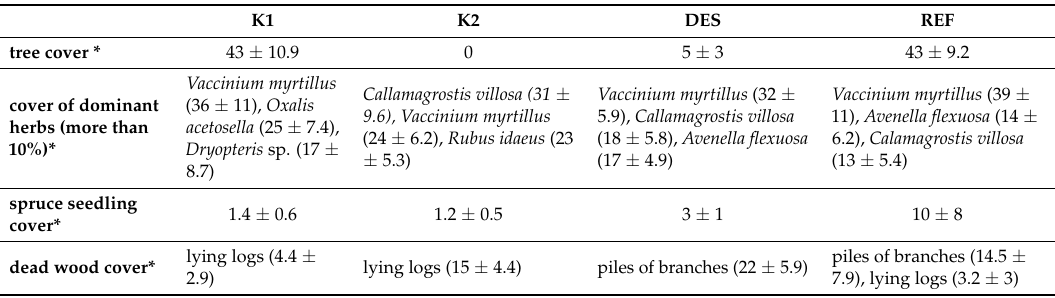
Table 2. Mean cover of trees, dominant herbs, spruce regeneration, and dead wood mass in forests: K1 = attacked by bark beetle, K2 = destroyed by bark beetle, DES = with removed trees; REF = mature. K1 K2 DES REF tree cover